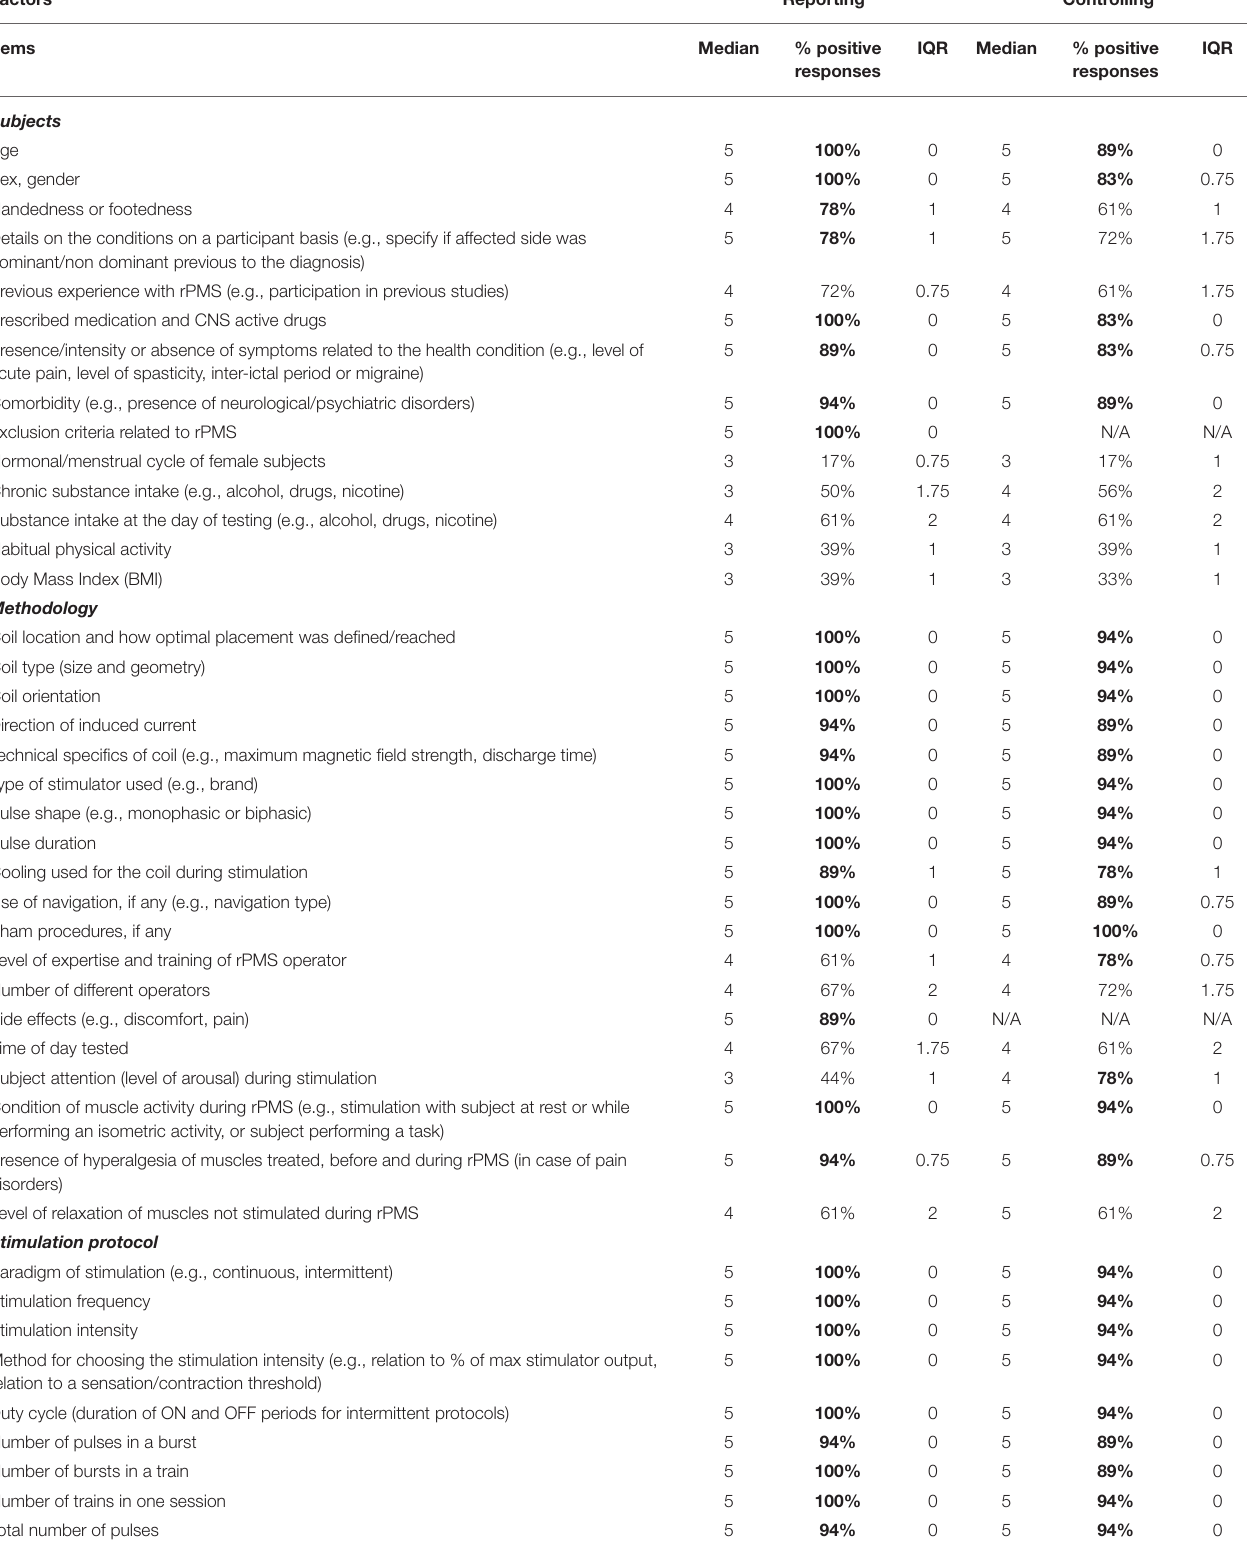
TABLE 2 | Results per item after the second round of the DELPHI study (median scores and IQR).